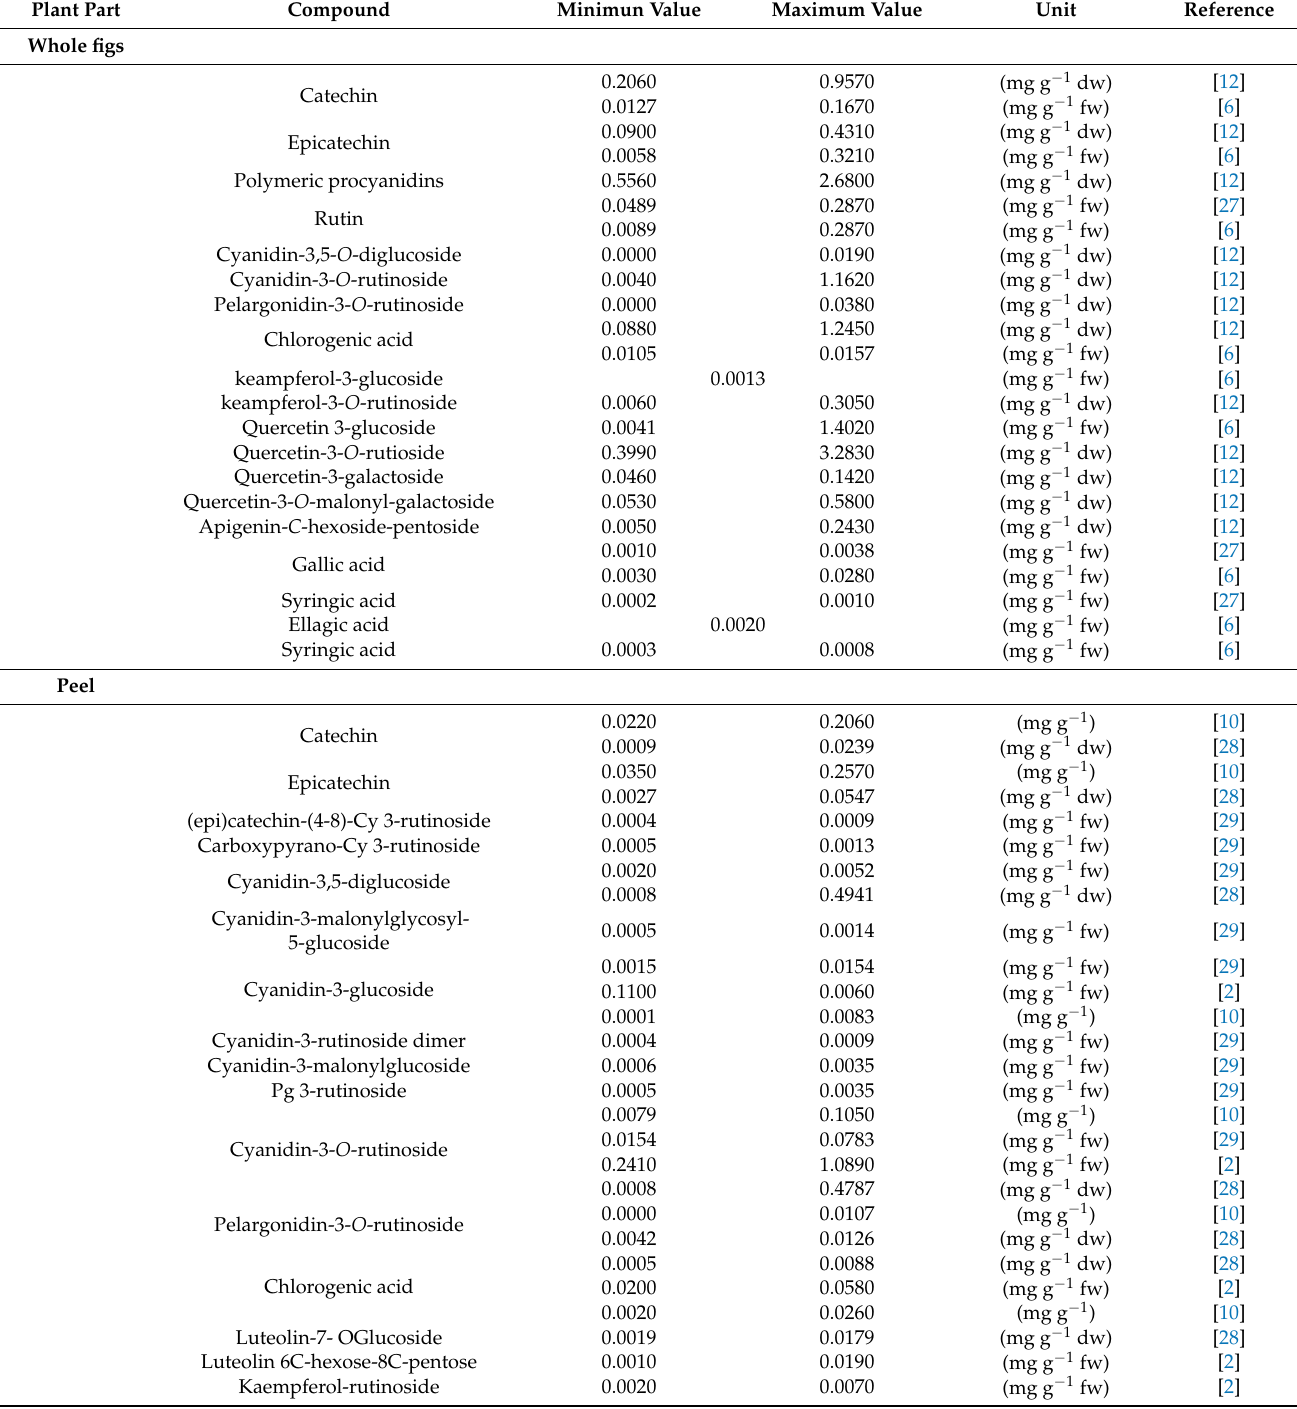
Table 1. Bioactive compounds and their content (minimum and maximum) in fig whole fruits, peel, pulp and leaves. Plant Part Whole